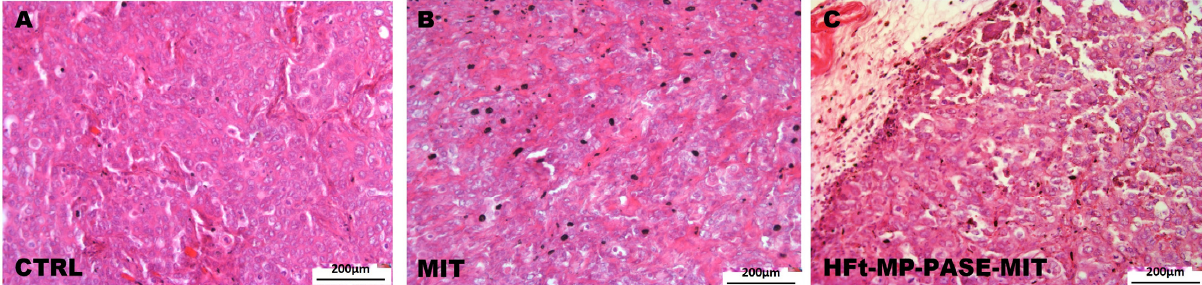
Figure 5. Histology of primary tumor mass. Images show the parenchyma of primary tumors in all the experimental groups. ( A ) A representative image of primary tumor mass collected from the control group treated with saline; ( B ) mice treated with free MIT; ( C ) mice treated with HFt-MP-PASE-MIT.